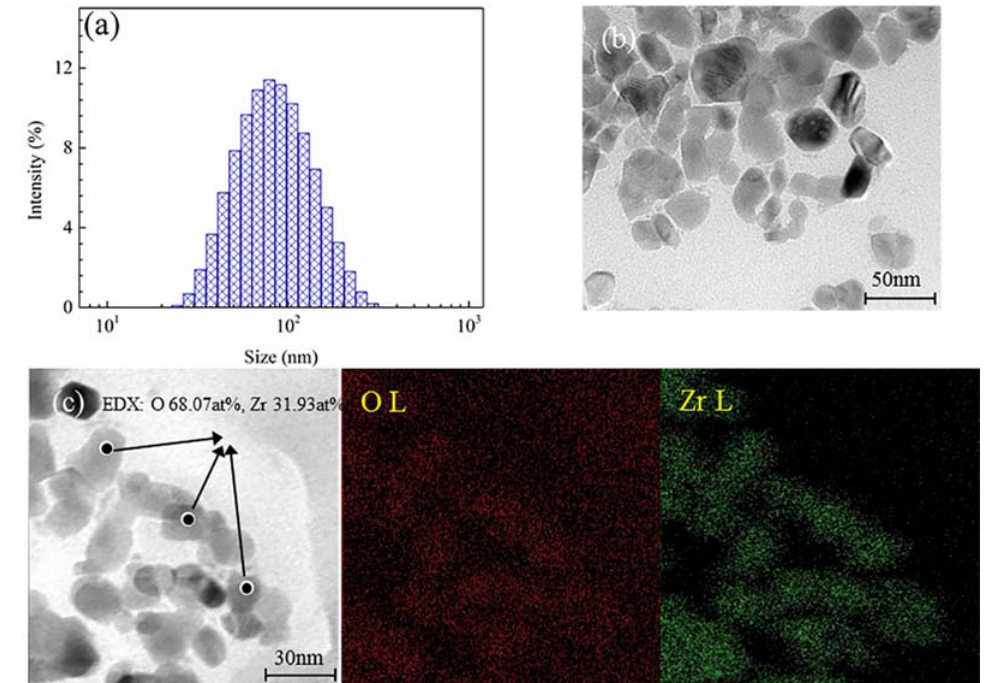
Figure 1. Size distribution ( a ), TEM micrograph ( b ), and chemical element mapping ( c ) of nano-ZrO 2 concentrates.